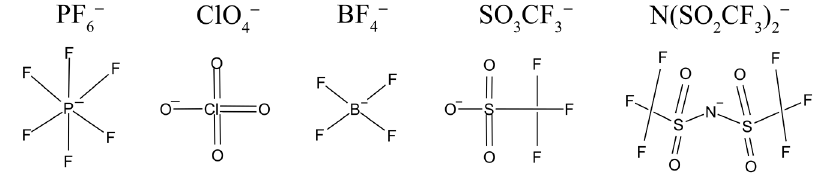
Figure 1. Lithium salt anions are commonly used in electrolytes of LIBs.